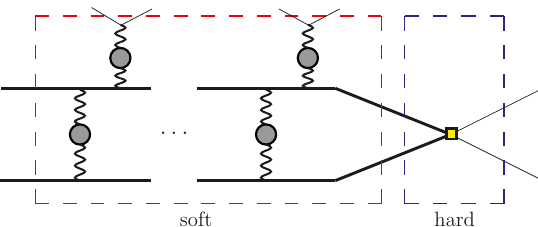
Figure 1 . An illustration of the repeated interactions of the dark matter particles with plasma constituents and each other, before the annihilation into Standard Model particles takes place. Thick lines stand for dark matter particles, thin lines for Standard Model particles, and wiggly lines for gauge bosons. The blobs indicate that because of infrared sensitivity Hard Thermal Loop resummed propagators need to be used for gauge bosons. The red (blue) dashed box encompasses the soft (hard) interactions. The soft interactions comprise both virtual and real corrections, and the dots stand for iterations resummed through the Schr(cid:127)odinger description. The hard process, with a large energy release of order M , converts dark matter particles into Standard Model